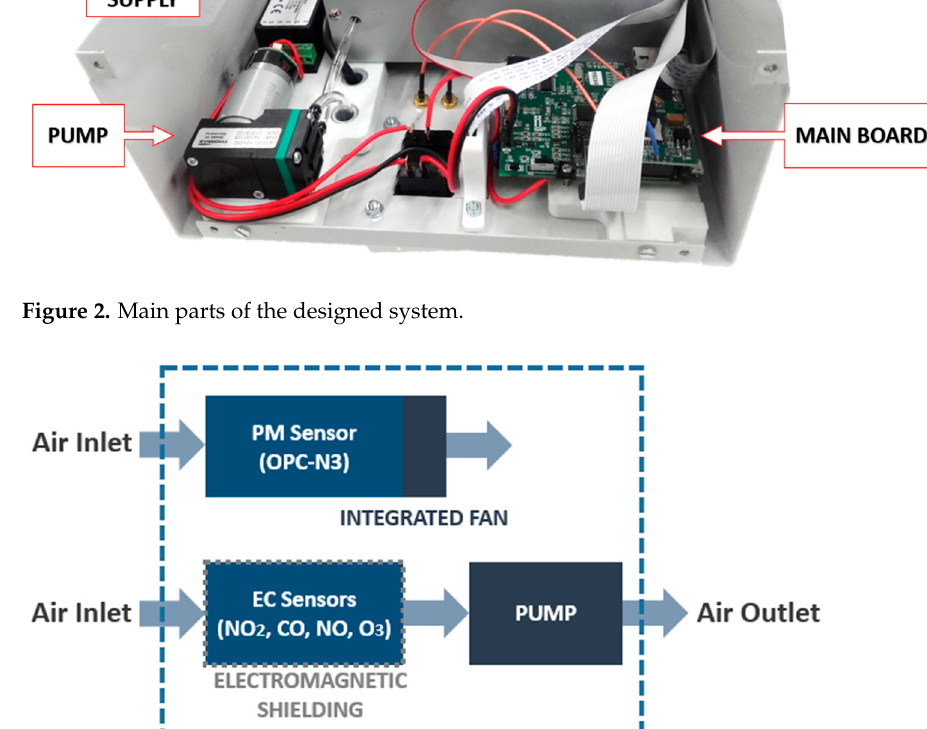
Figure 2. Main parts of the designed system.